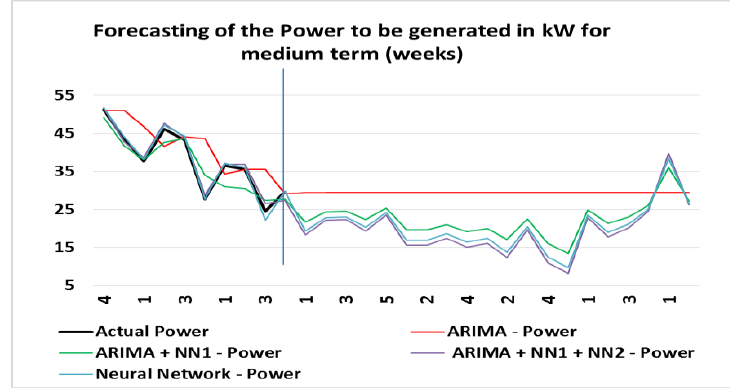
Figure 15. Forecasting of generated power in kW for medium term (weeks).